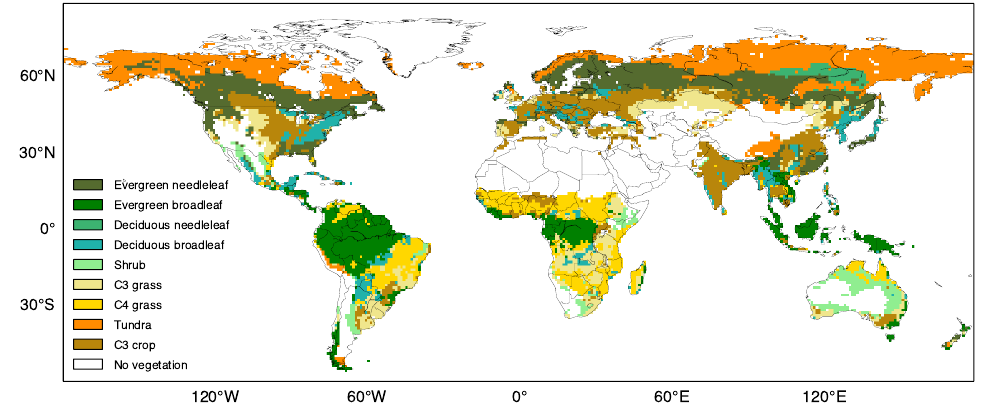
Figure 2. Map showing the plant functional types (PFTs) currently used in CABLE (Lawrence et al., 2012). CABLE also has C4 crop, wetland and urban PFTs, however these are currently not